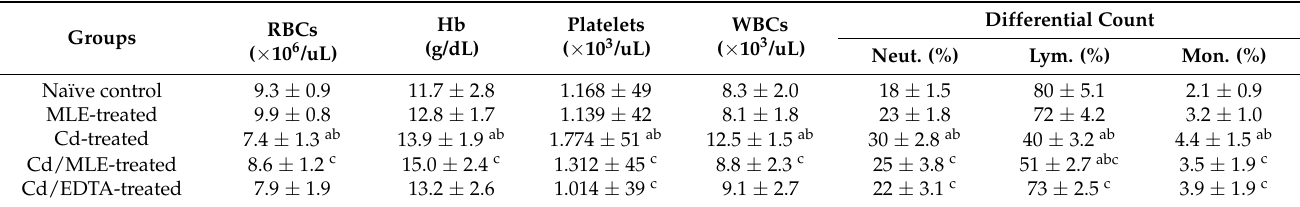
Table 4. Complete blood count in the different groups of mice under the